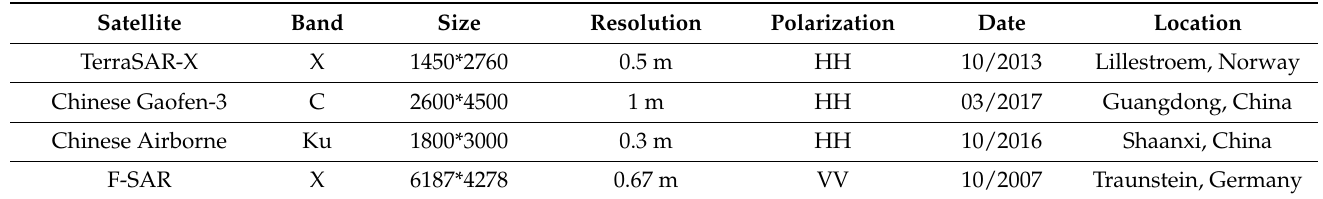
Table 1. Detailed information on real HR SAR images.